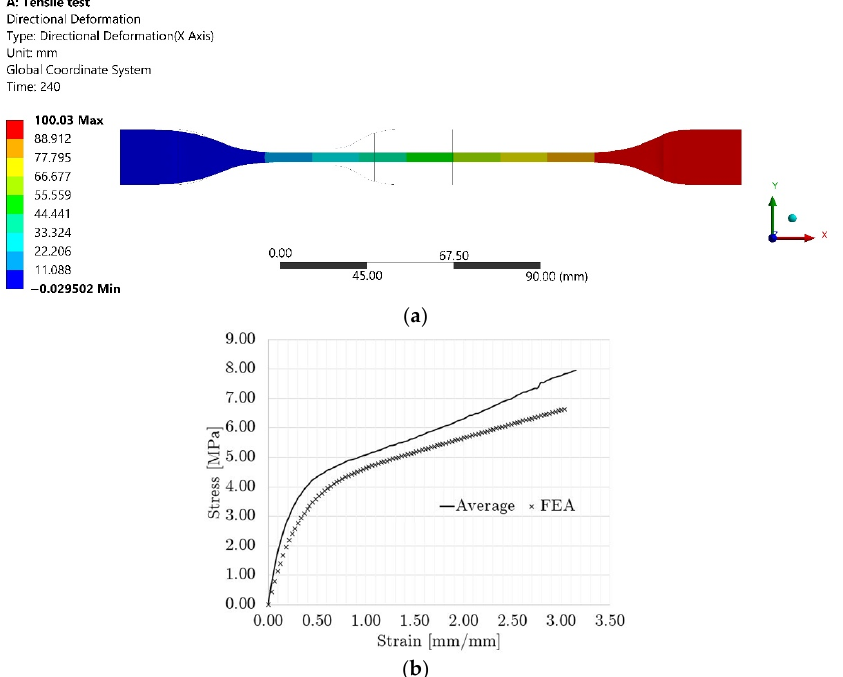
Figure 6. Modeling results for tensile test: ( a ) Final displacement and ( b ) Stress–strain curve com ‐ parison.